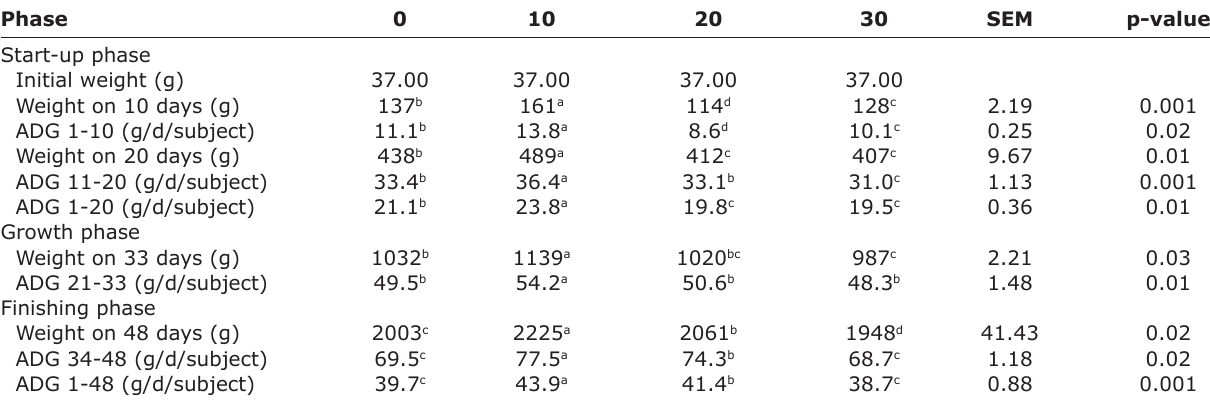
Table-3: Changes in weight growth and ADG (g/d/subject) during the start-up, growth, and finishing phases as a function of substitution rates.